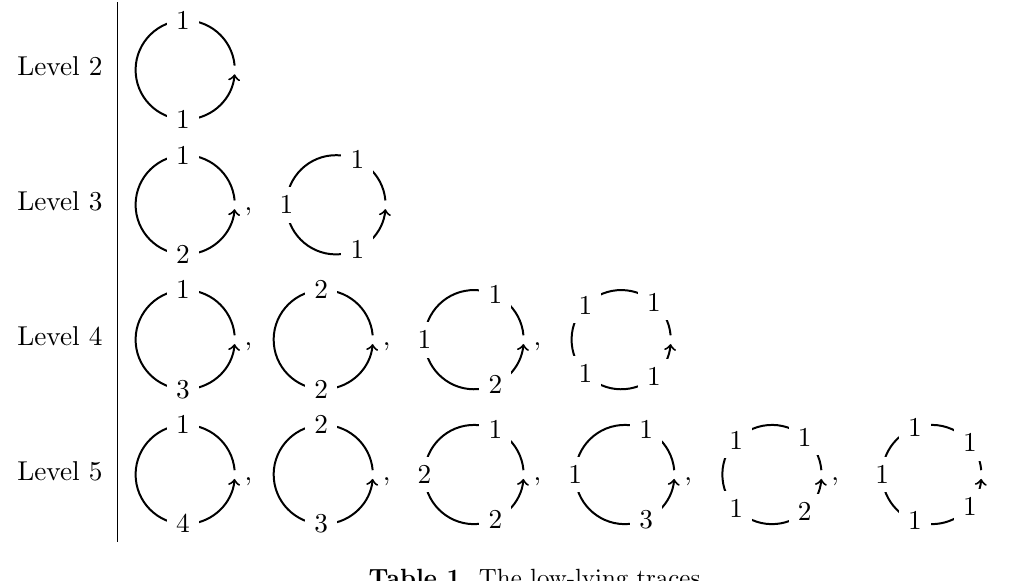
Table 1 . The low-lying